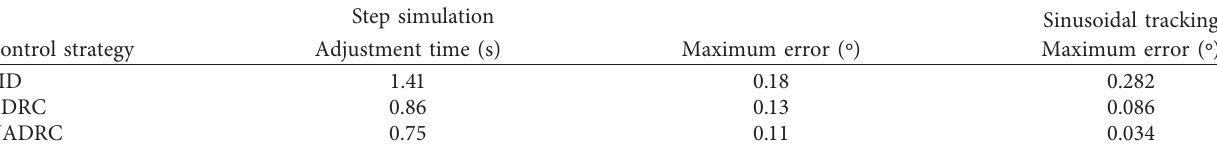
Figure 10: Sinusoidal tracking error. Table 1: Parameters in